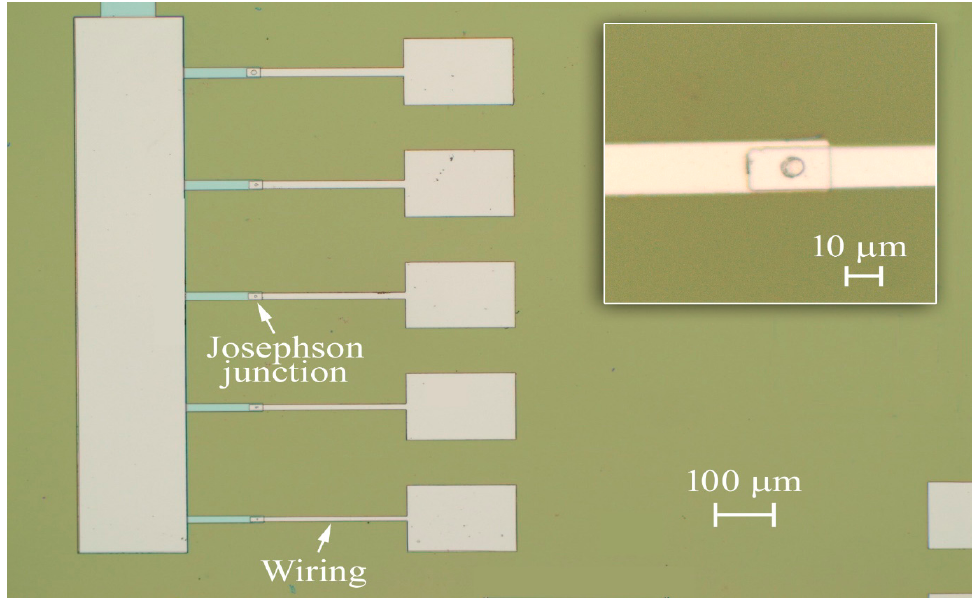
Figure 2. Optical microscope image of a set of circular SIS’FS having a diameter ranging from 2 to 10 μ m. In the inset, the magnification of a circular junction with a diameter of 4 μ m is displayed.